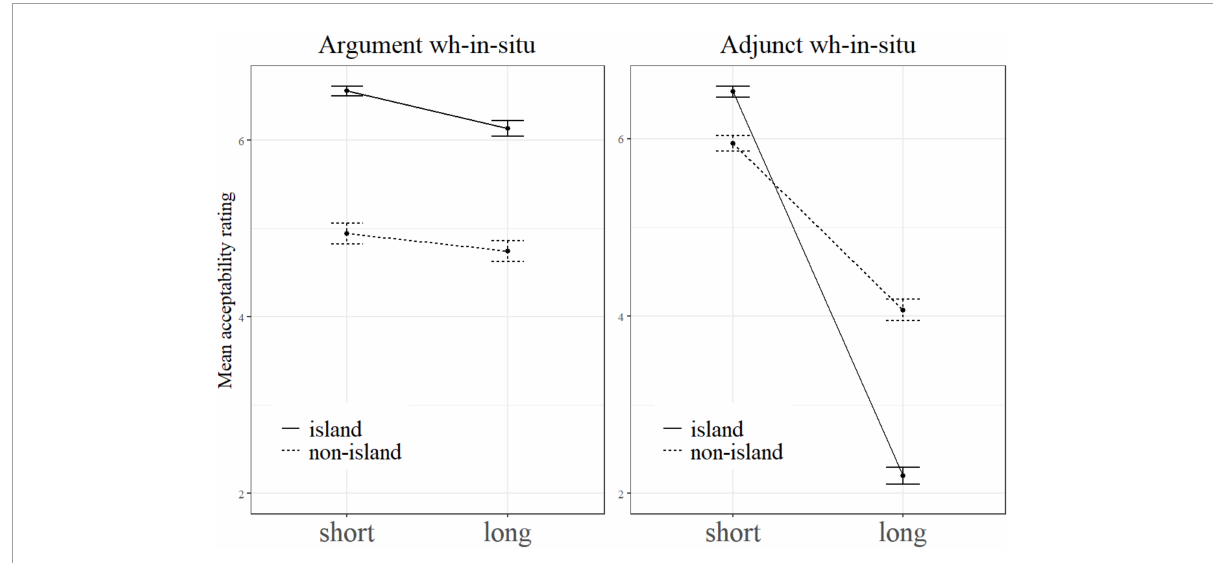
FIGURE1 The interaction plots for argument wh -in-situ and adjunct wh